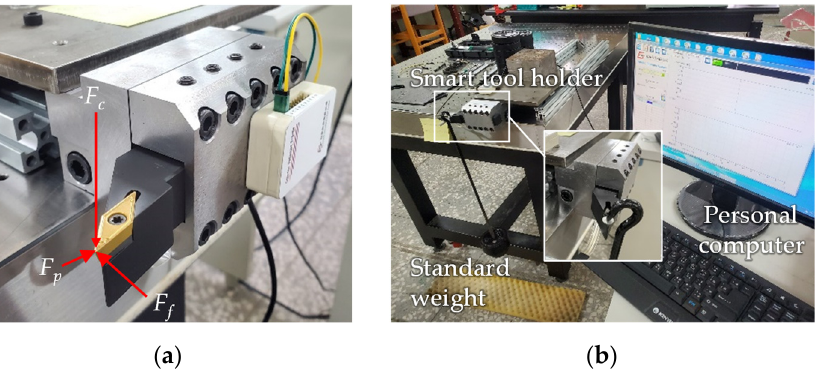
Figure 9. The static load test of the smart tool holder: ( a ) the turning tool and smart tool holder clamped on the optical table in order to simulate their installation on the turret; and ( b ) the experiment setup of the static load test.